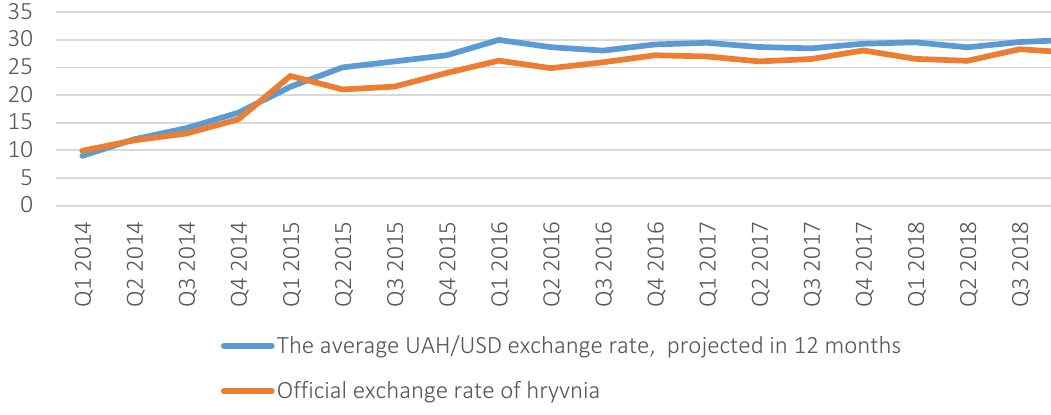
Figure 8. Expectations of business, 2014–2018, UAH per USD